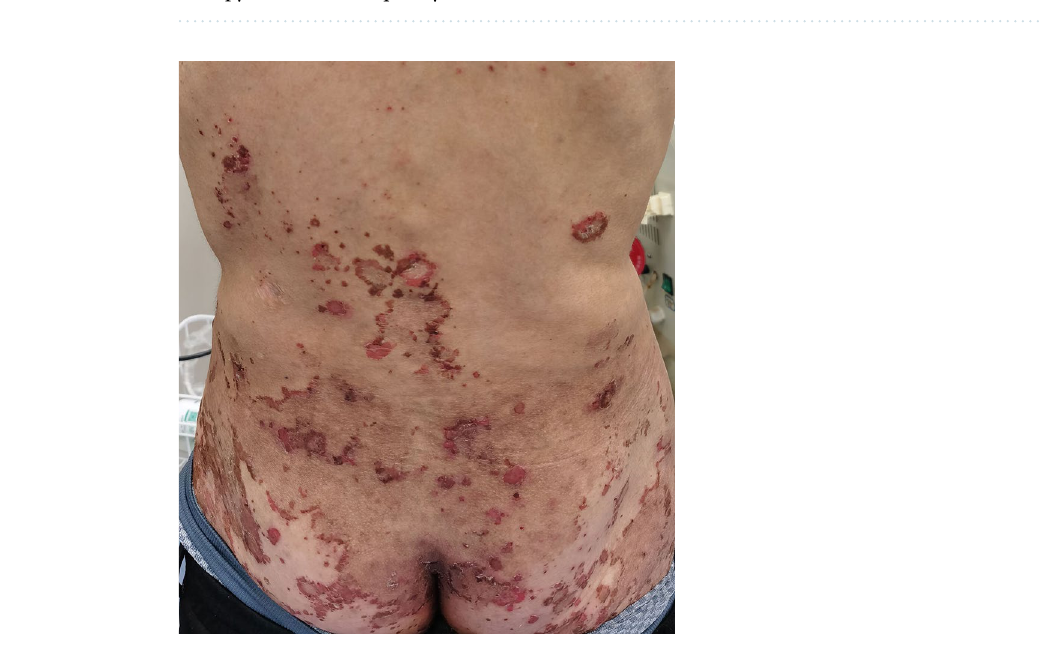
Figure 1. NME of glucagonoma. Skin lesions affecting lower back and gluteal regions. The boundary of the rash is not clear. Erosion, exudation and necrosis can be seen in the center of some erythematous lesions.